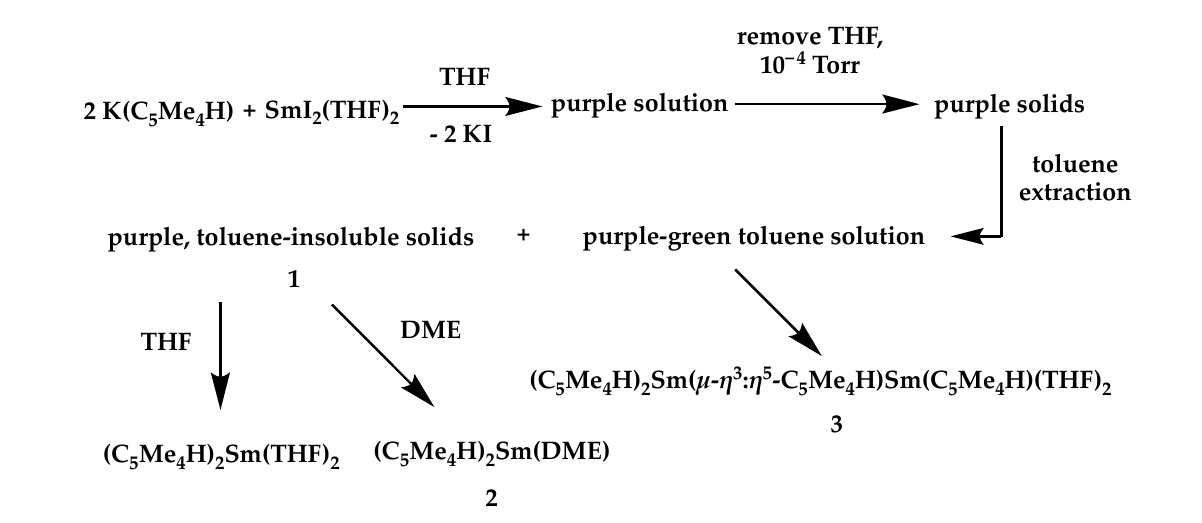
Scheme 2. Synthetic and workup procedure for the different products of the reaction between SmI 2 (THF) 2 and 2 K(C 5 Me 4 H) in THF.